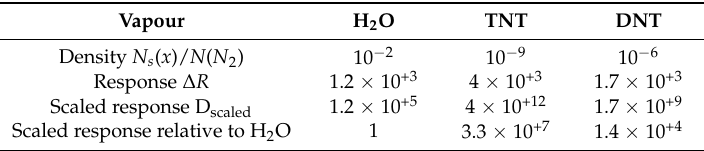
Table 2. Density of molecules for different vapours together with responses and scaled responses of APhS